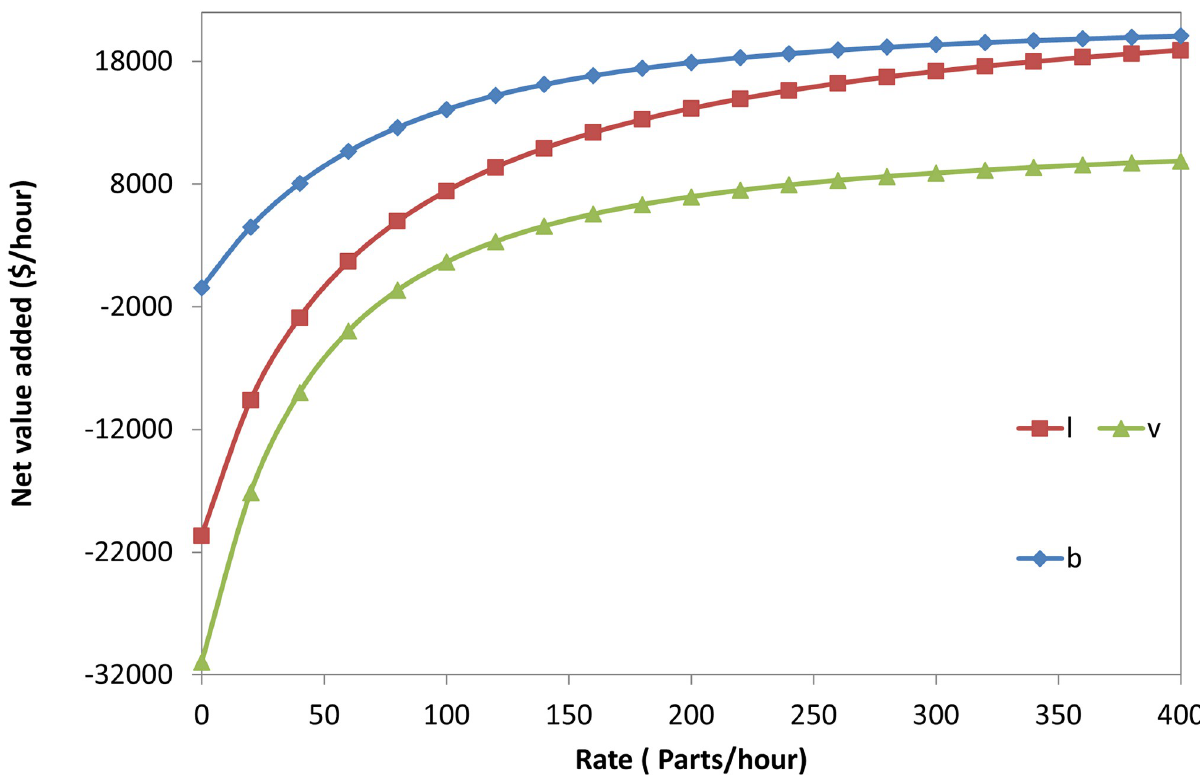
Fig 21. The net value added for a single-machine FMC versus the system